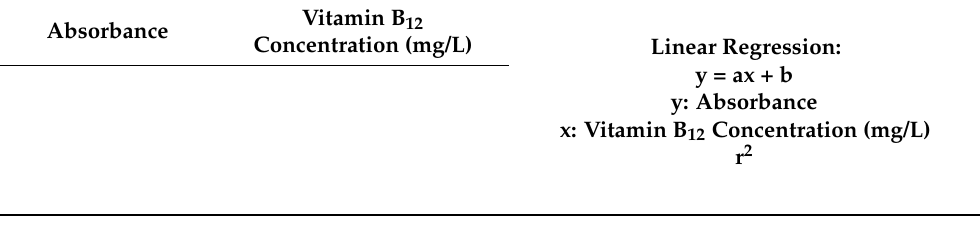
Table A4. Calibration curve.